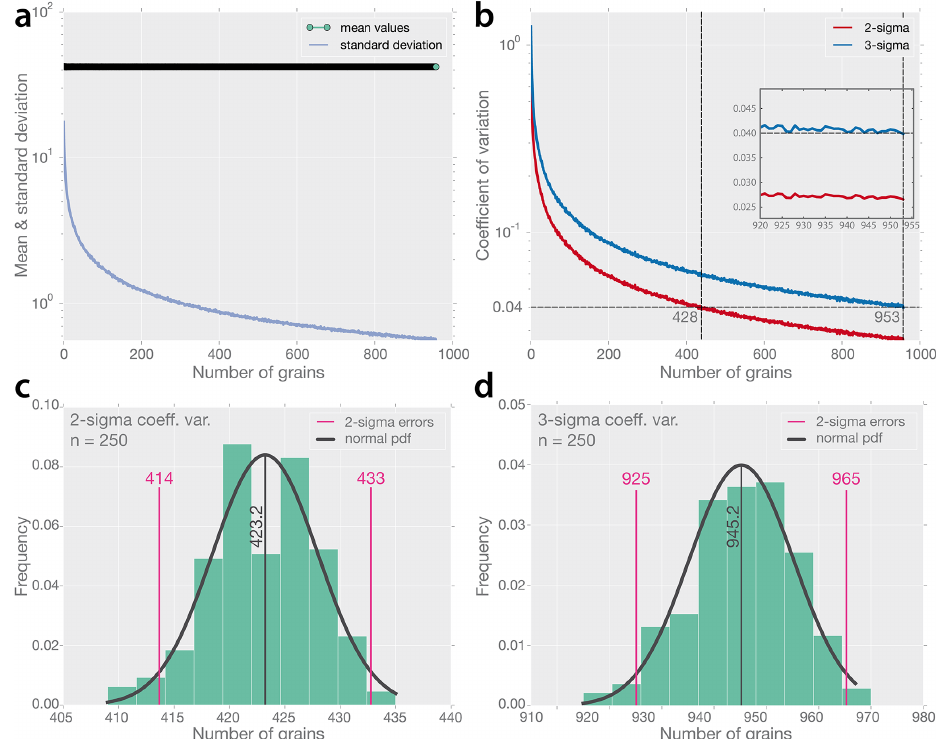
Figure 7. Results of the Monte Carlo simulations to find the number of grains necessary to achieve reproducibility using a natural dynamically recrystallized mylonite (sample MAL-05) and the mean grain size. (a) Evolution of the mean and the standard deviation during the increase of sample size. Note that the mean barely changes its value due to the large number of runs (5000) used in each sample size while the standard deviation declined monotonically as we increased the number of grains. (b) Evolution of the coefficient of variation ( σ /mean) using the sigma-2 and sigma-3 values during the increasing of sample size. In this particular simulation, the plot shows that when 428 (for 2-sigma) or 953 (for 3-sigma) grains are measured, the coefficient of variation of the mean grain size obtained is below 4%. The inset in (b) shows a linear scale. (c, d) Minimum number of grains obtained by repeating the previous simulation 250 times and using the 2-sigma and 3-sigma values to estimate the coefficient of variation respectively. Pdf means probability density